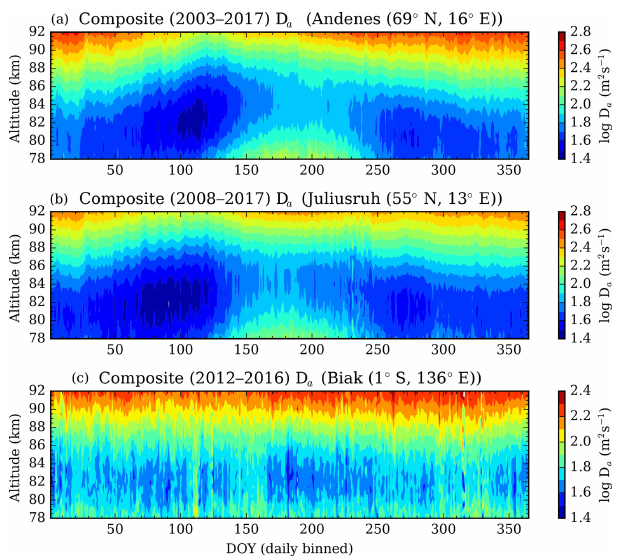
Figure 2. Representative yearly diffusion values obtained by di- rectly converting the WACCM+DART 2007 temperatures over the three stations. They show nearly similar seasonal variability, except the increased meteor trail diffusion at lower altitudes seen in Fig. 1. Also, the summer enhancement seen in Fig. 1 is not visible here. This implies that the enhanced diffusion is related to factors that are other than temperature